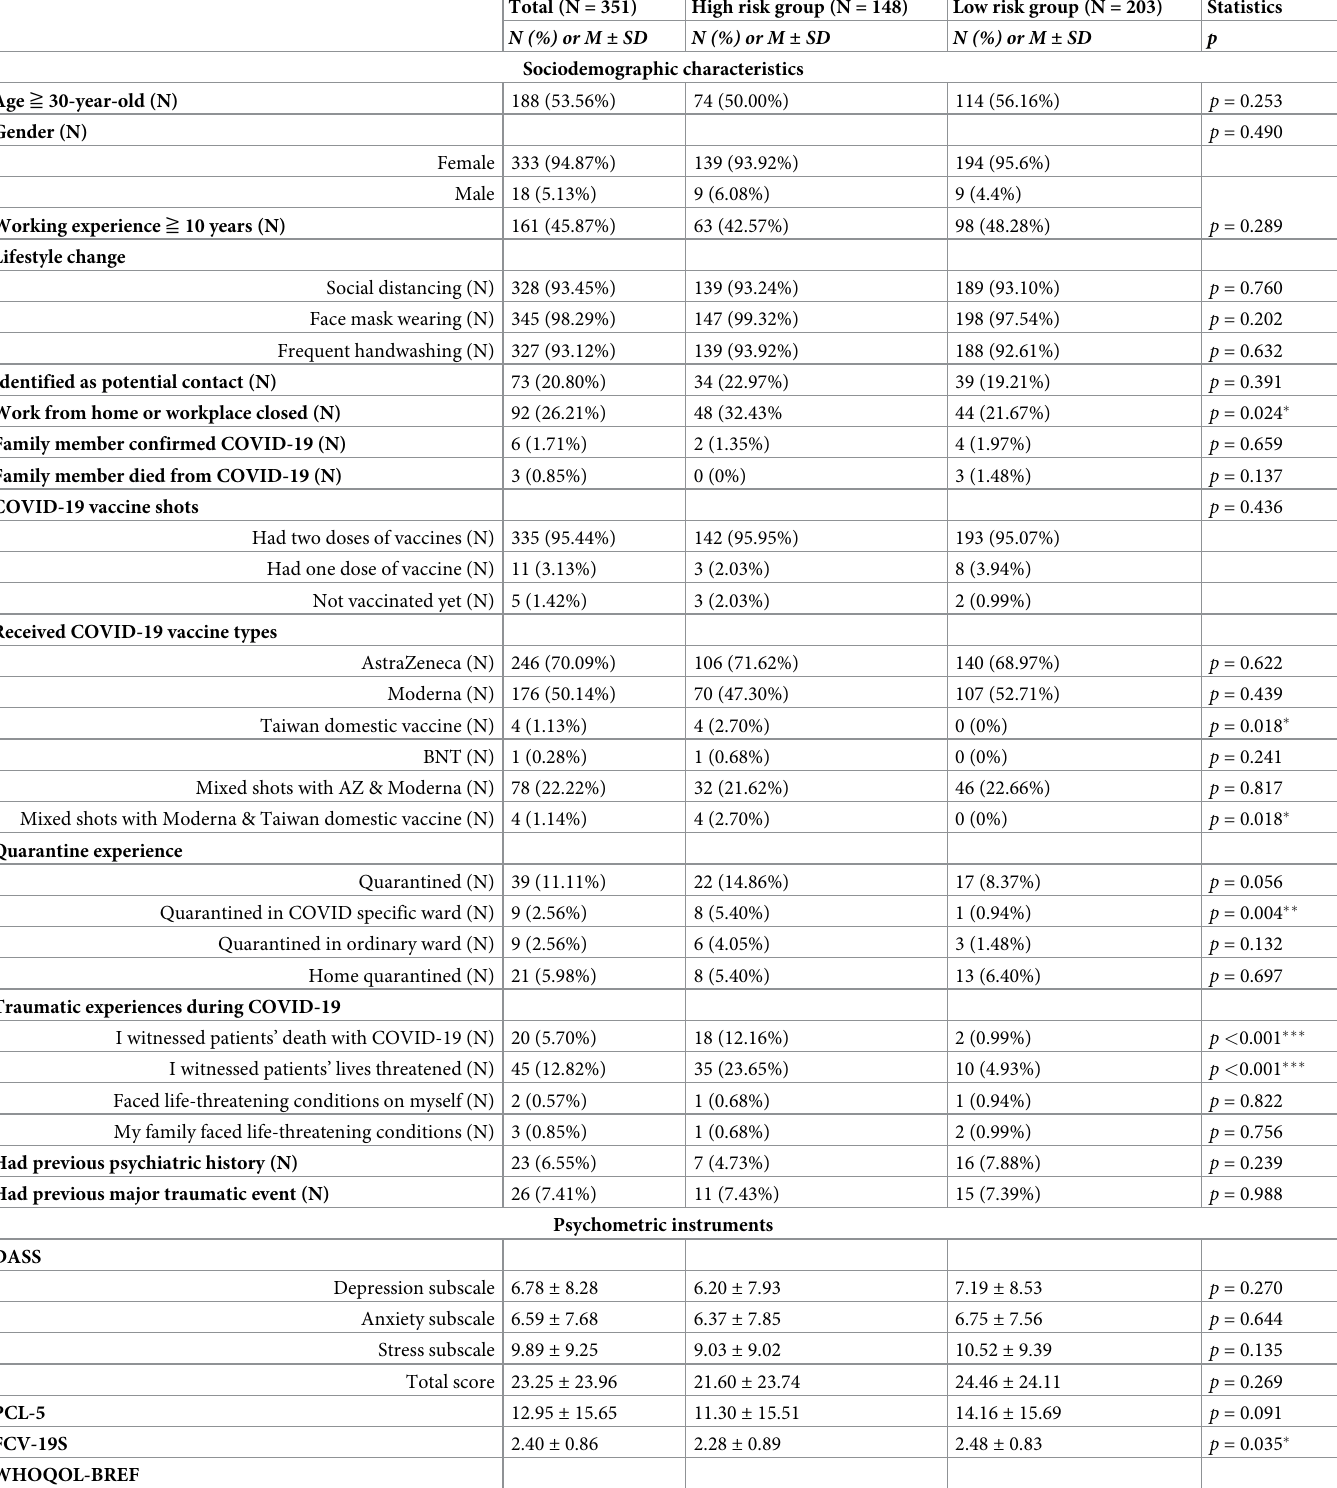
Table 1. Comparison of demographics of nurses in high-risk and low-risk